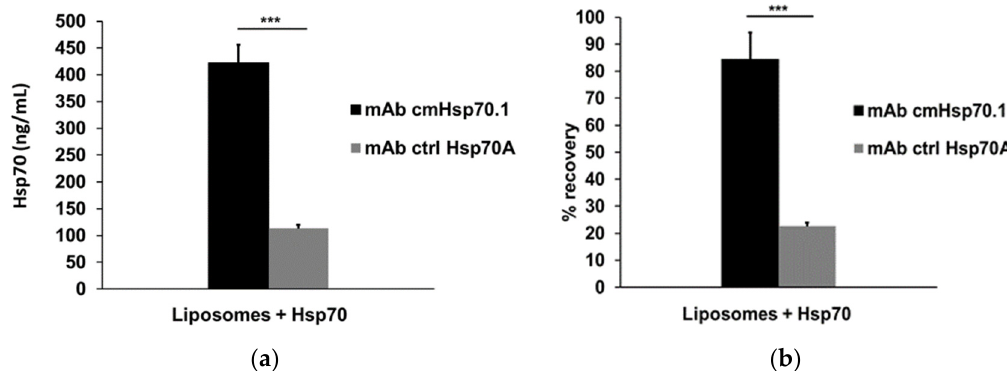
Figure 4. Detection and recovery of liposomal Hsp70 in serum. Quantification ( a ) and recovery ( b ) of lipid-bound Hsp70 in artificial lipid vesicles (liposomal Hsp70: 500 ng/mL), as determined by the sandwich Hsp70 ELISA using the cmHsp70.2 mAb as a coating antibody, and cmHsp70.1 and ctrl Hsp70A mAbs as detection antibodies. The data represent mean values of three independent experiments, *** p < 0.001, a two-sided t -test was used.